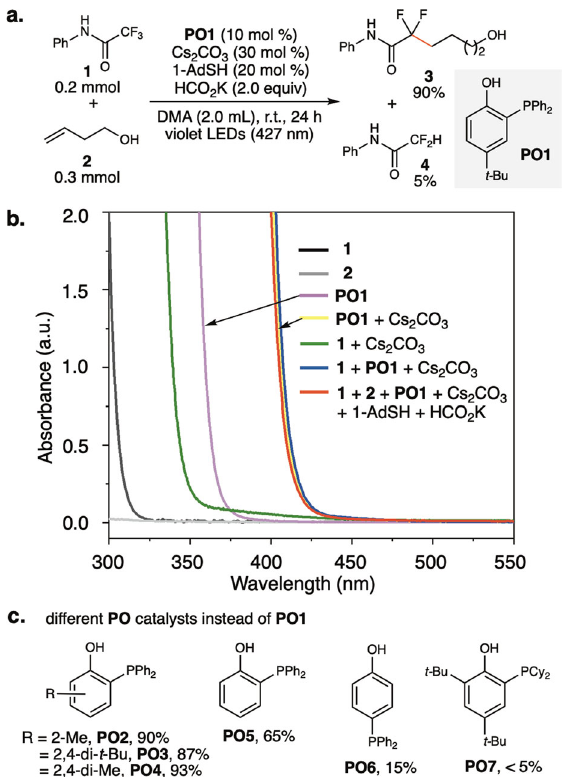
Fig. 2 De fl uoroalkylation of tri fl uoroacetamide with an alkene. a Optimized reaction condition. b UV – Vis absorption spectra of catalyst, substrates, and reaction mixtures. The concentrations of substances measured were identical to those under optimized reaction conditions in Fig. 2a. Arbitrary units (a.u.) c PO catalysts other than PO1